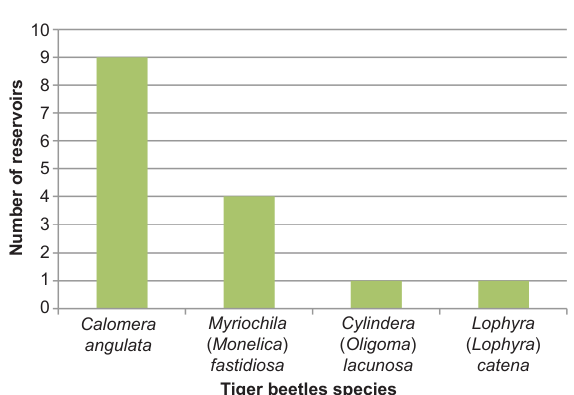
Figure 2. Distribution of Tiger Beetle species in reservoir ecosystems of Sri